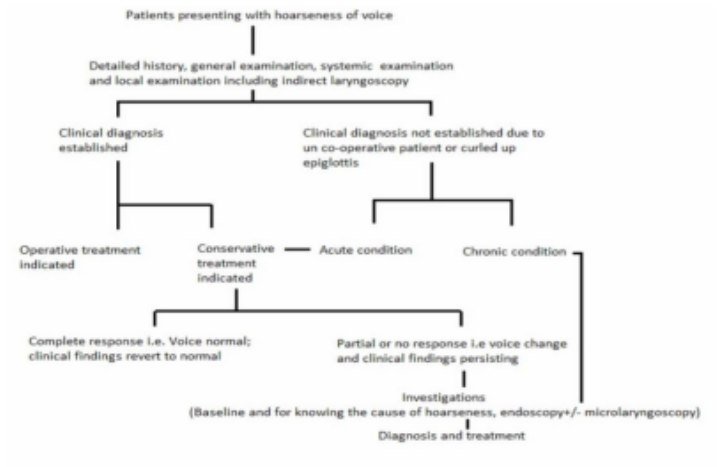
Figure 1. Flowchart showing work-up of patients with hoarseness of